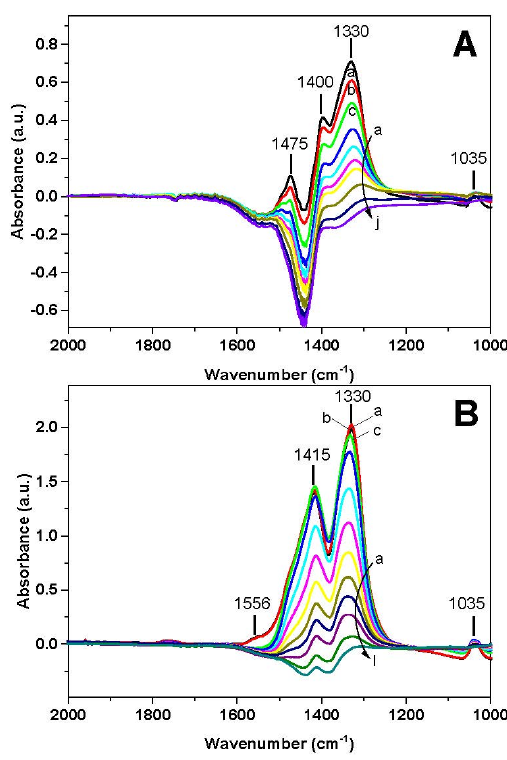
Figure 8. Operando FT ‐ IR spectra obtained during H 2 ‐ TPSR experiments with H 2 (2000 ppm) from 40–400 °C (4 °C/min) after NO/O 2 adsorption at 350 °C over ( A ) Rh ‐ BaO/Al 2 O 3 at: ( a ) 157 °C; ( b ) 200 °C; ( c ) 215 °C; ( d ) 232 °C; ( e ) 248 °C; ( f ) 264 °C; ( g ) 281 °C; ( h ) 322 °C; ( i ) 355 °C; ( j ) 388 °C, and ( B ) Pt ‐ BaO/Al 2 O 3 at: ( a ) 40 °C; ( b ) 49 °C; ( c ) 107 °C; ( d ) 115 °C; ( e ) 124 °C; ( f ) 132 °C; ( g ) 140 °C; ( h ) 148 °C; ( i ) 157 °C; ( j ) 165 °C; ( k ) 182 °C; ( l ) 198 °C (rig#3).